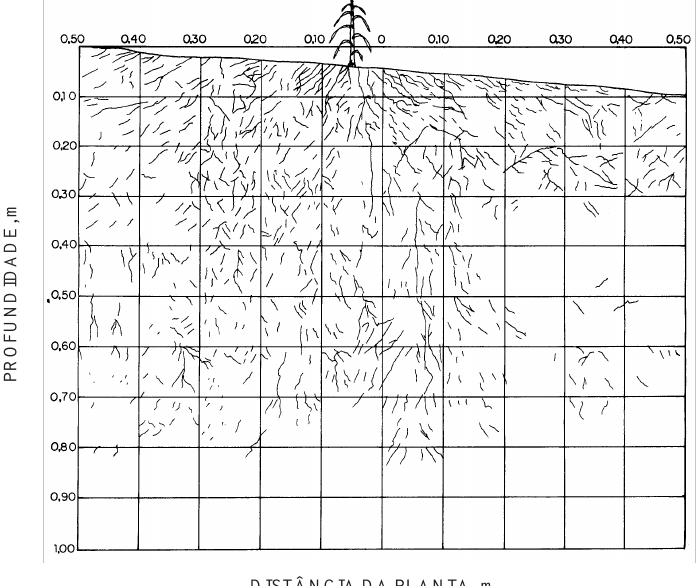
Figura 2. Distribuição radicular da cultura do milho no perfil cultural com horizonte A profundo. Espessura dos horizontes: Ap1: 0-0,18 m; A2: 0,18-0,45 m; E: 0,45-0,70 m; BE: 0,70-0,83 m; B